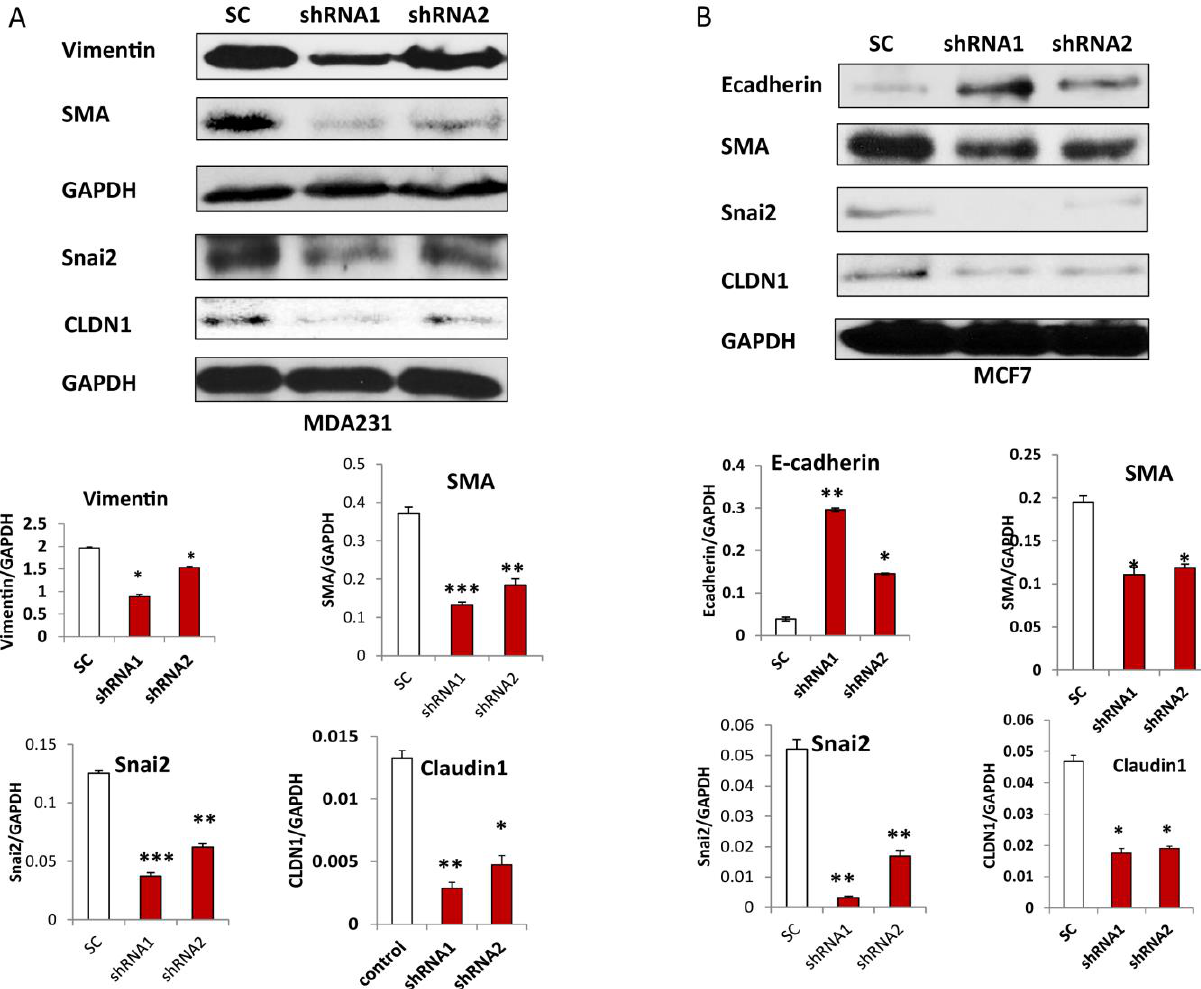
Figure 6. Silencing CLDN1 inhibits EMT in breast cancer cells. ( A , B ) EMT marker gene expression was detected in MDA-MB-231 and MCF7 cells transduced with CLDN1 shRNA and SC controls by Western blot, respectively. A representative Western blot was presented from three independent experiments. (* p < 0.05; ** p < 0.01; *** p < 0.001).